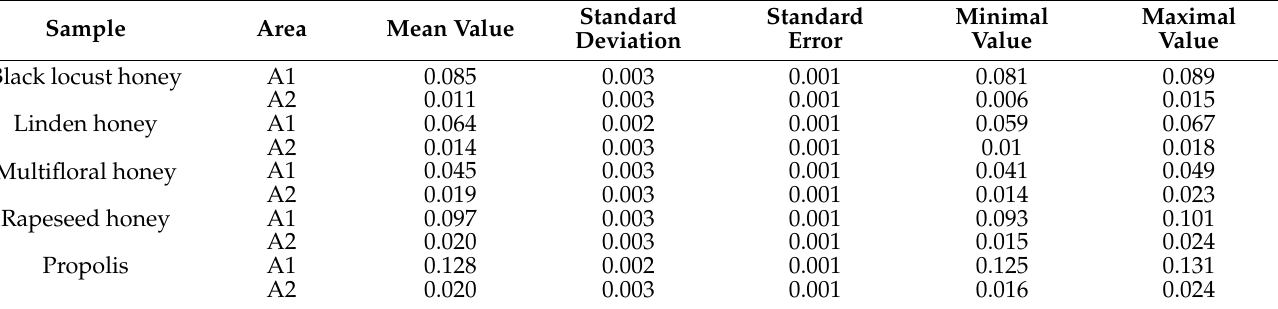
Table 7. Bioconcentration factor for Cu.